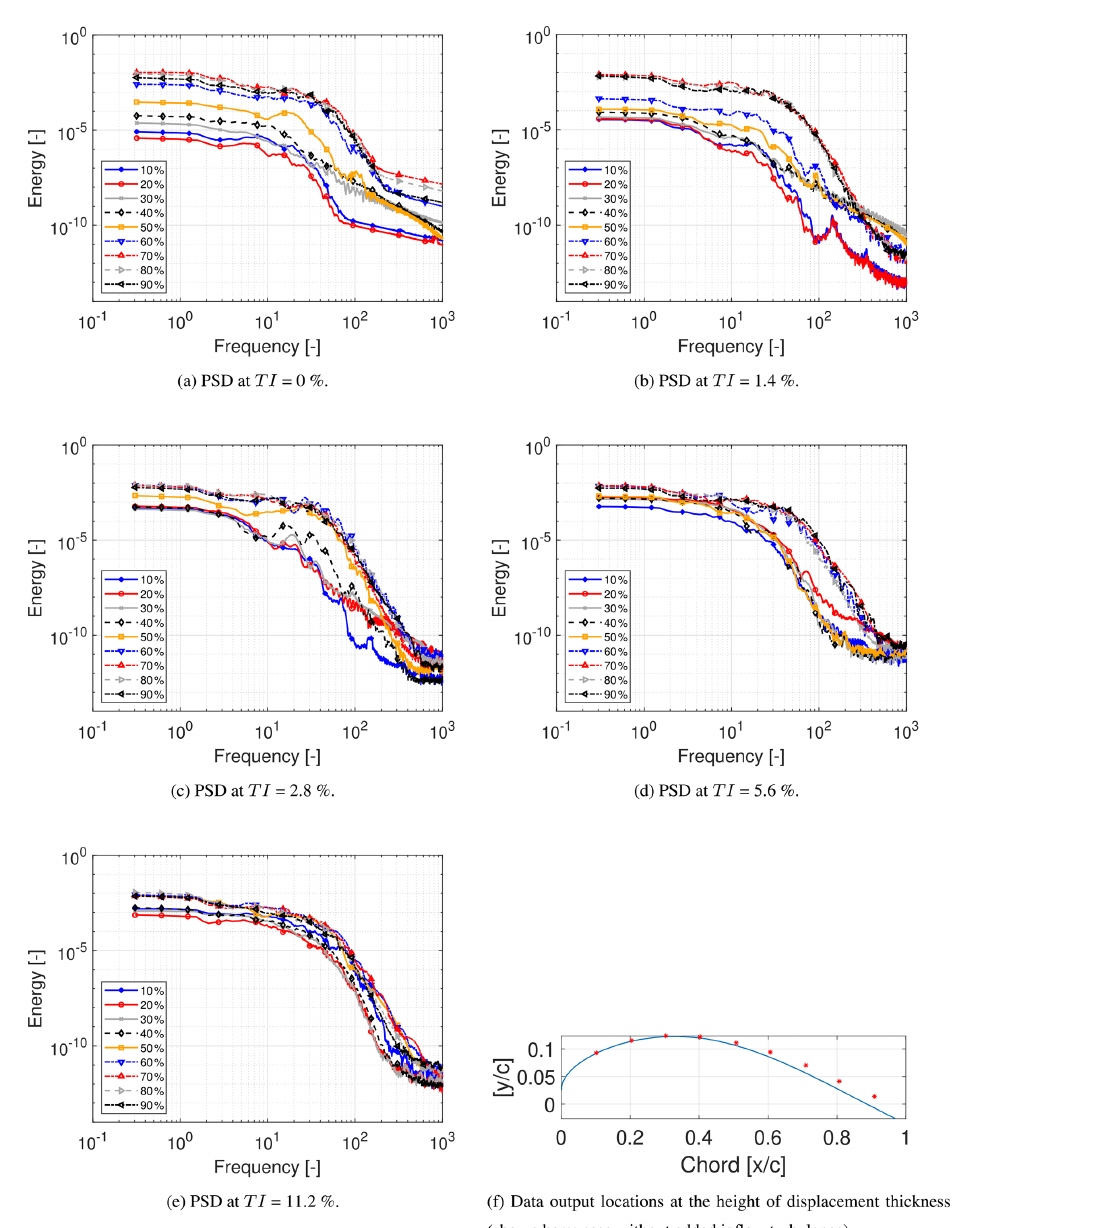
Figure 10. Power spectral density at different TIs determined at the height of the displacement thickness in the mid-span at every 10%